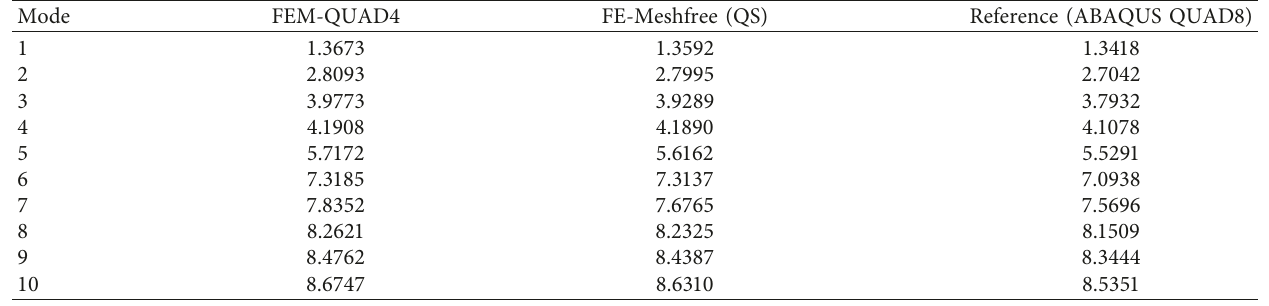
10 6 rad/s) of connecting ×